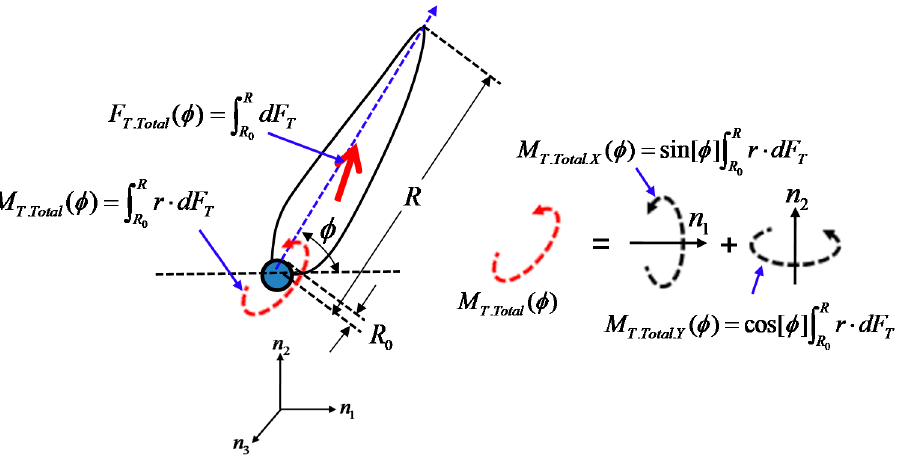
Figure 3. Total axial force F T . Total ( ϕ ) and moment M T . Total ( ϕ ) induced by F T . Total ( ϕ ) .